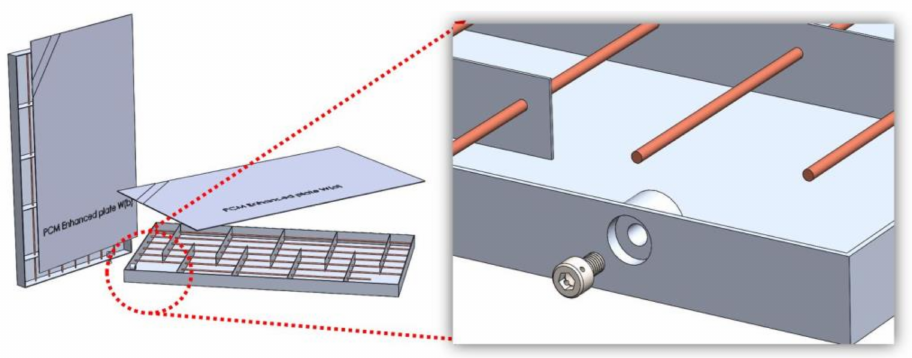
Figure 19. Enhanced PCM macro-encapsulating